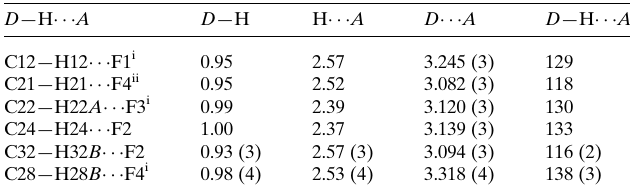
Table 1 Hydrogen-bond geometry (A˚ , (cid:5) ).